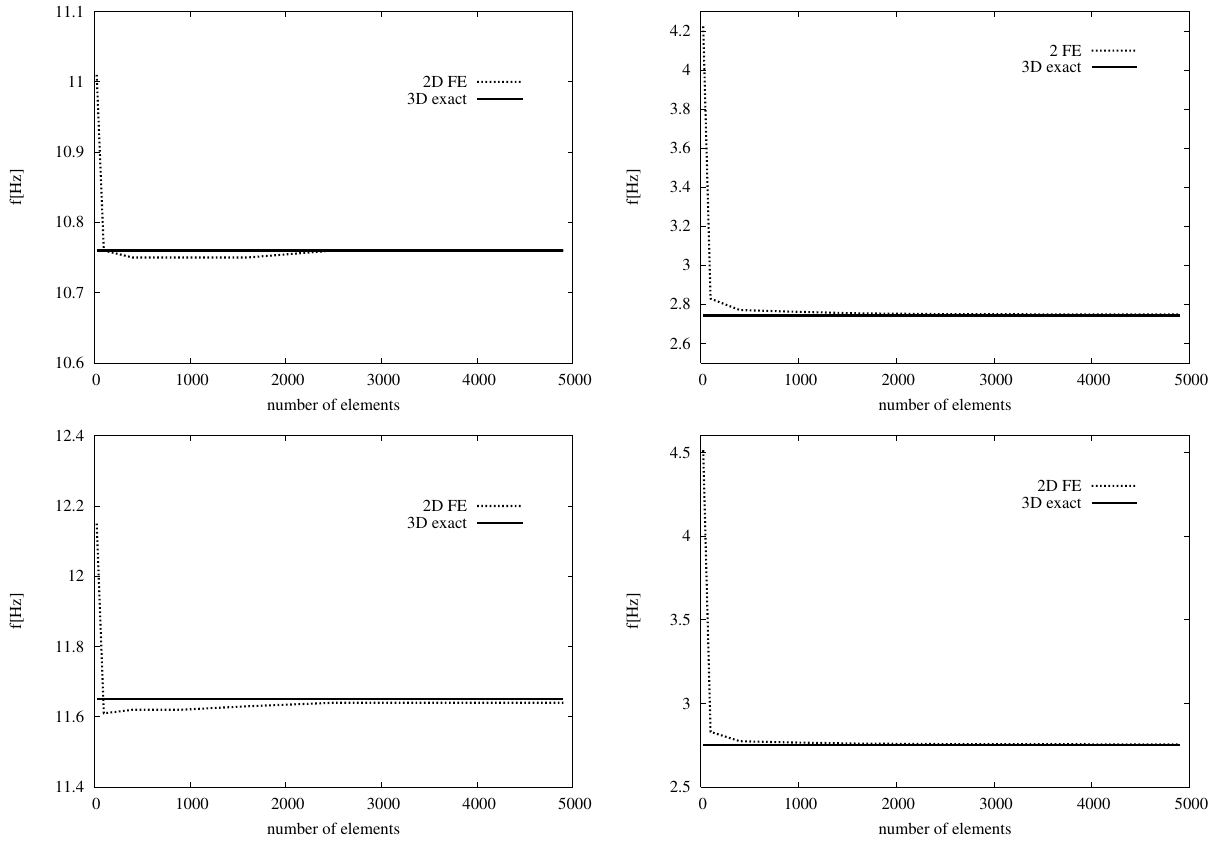
Figure 7: Second assessment for the 2D FE solution, simply sup- ported multilayered cylinder made of aluminium alloy and titanium alloy with thickness ratio R α /h=100. Frequency f[Hz] vs. number of elements for the mode (10,1) (at the top) and for the mode (12,1) (at the bottom).